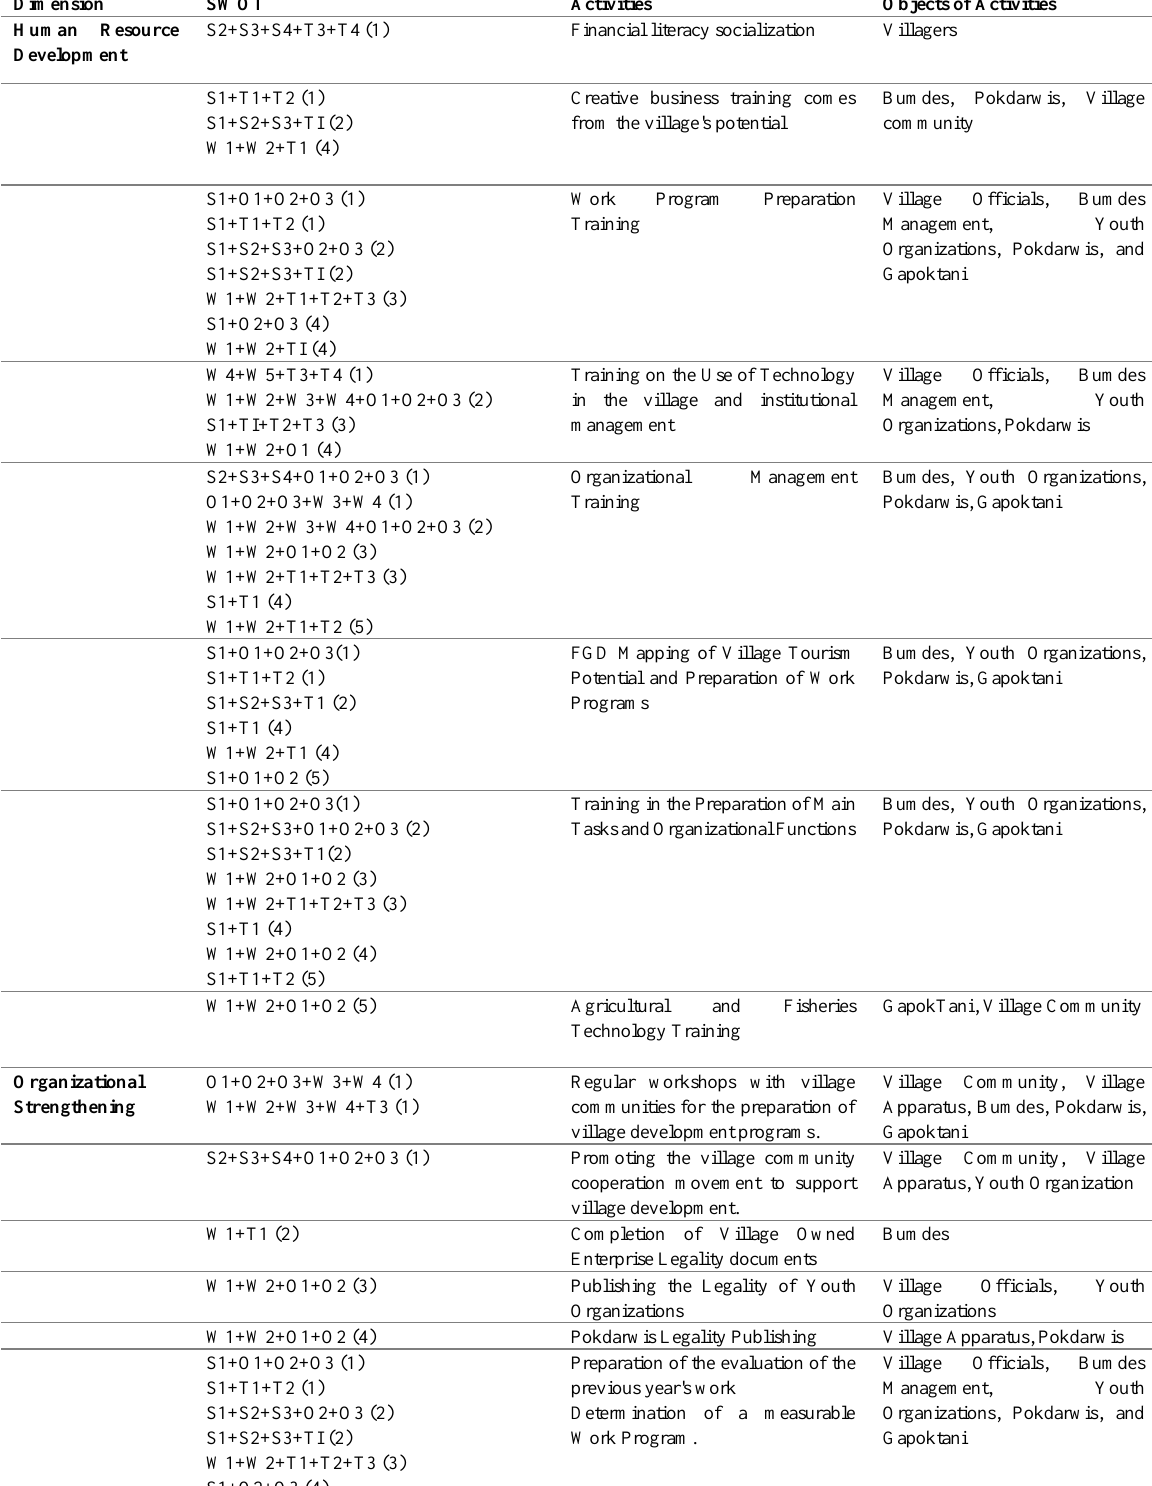
Table 5: List of Capacity Building